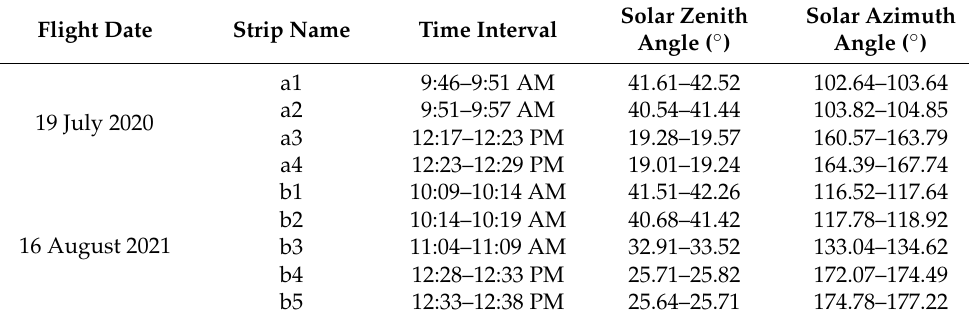
Table 1. Properties of multi-strip airborne hyperspectral images.